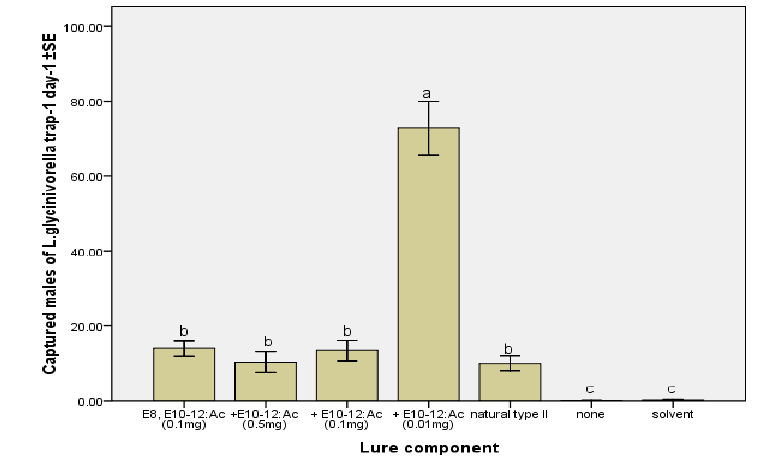
Figure 2. Mean (±SE) numbers of L. glycinivorella males captured per trap per day in traps baited with the binary blend of EE- 8,10-12:Ac and E- 10-12:Ac in different doses compared with control groups and natural type II (mixture of EE- 8,10-12:Ac and E- 10-12:Ac in a ratio of 2:5) [3] in rubber septa. The field test was conducted in a soybean field in Harbin, China from 7 August to 17 August 2011. Bars with different letters are significantly different (ANOVA and Tukey’s HSD, p < 0.05).